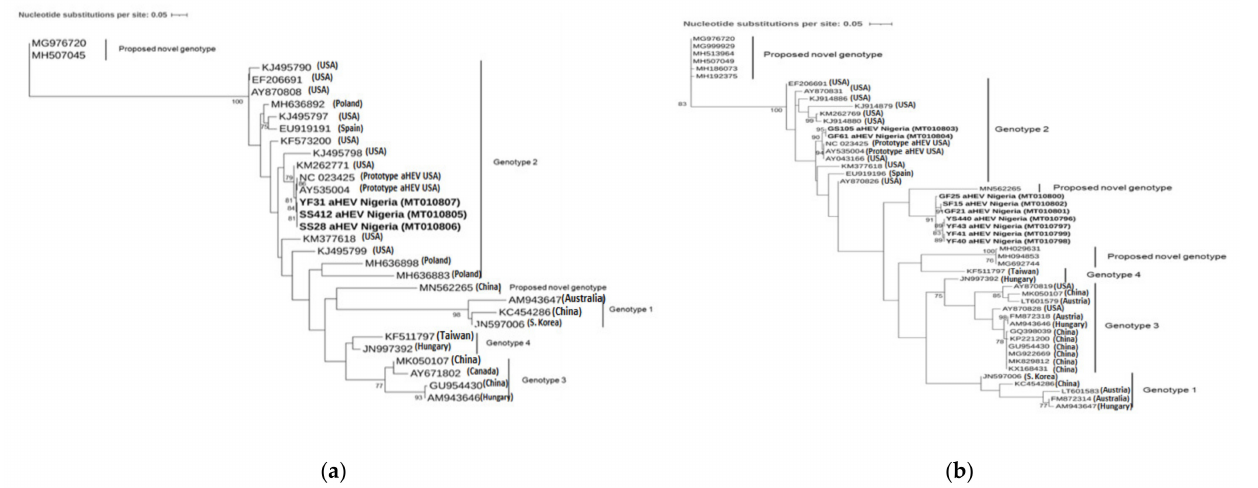
Figure 1. ( a ) Phylogenetic tree based on the 302 bp long nucleotide sequences of the partial helicase gene (ORF1) and ( b ) 194 bp long nucleotide sequence of the partial capsid gene fragment (ORF2) of the Nigerian isolates and other known aHEV strains. The evolutionary history was inferred by maximum likelihood method with the TIM3 +F + 1 + G4 and Tne + G4 model using IQTREE 1.6.12. Bootstrap values >75% are shown. The Nigerian aHEV isolates are in bold.